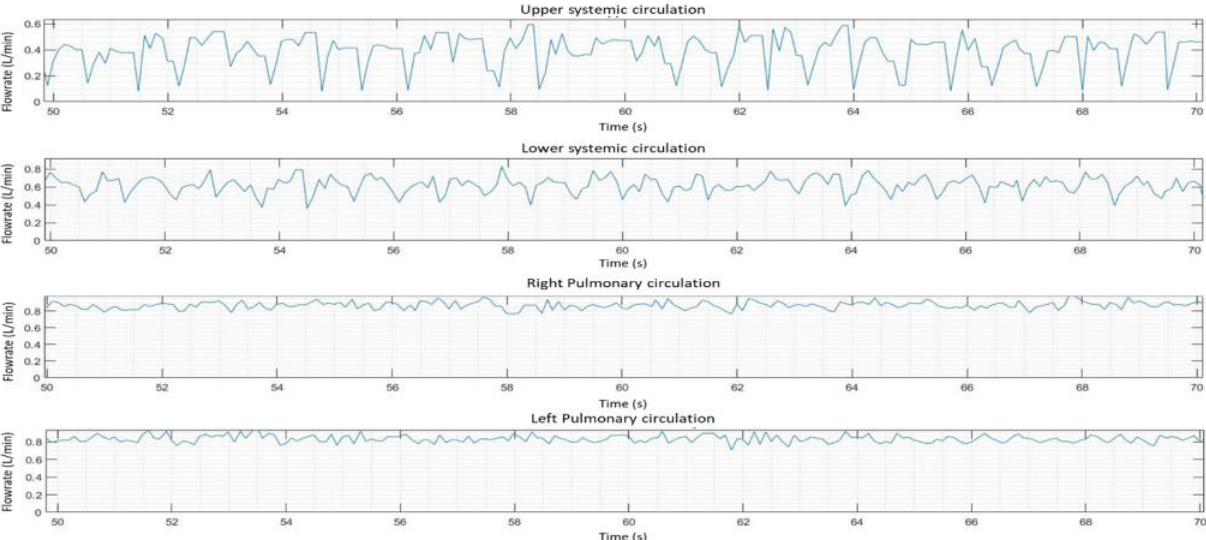
Figure 15. Unfiltered Flow waveform for 3 mm IJS with a reduced PVR of 30% degree anastomosis angle experiment.